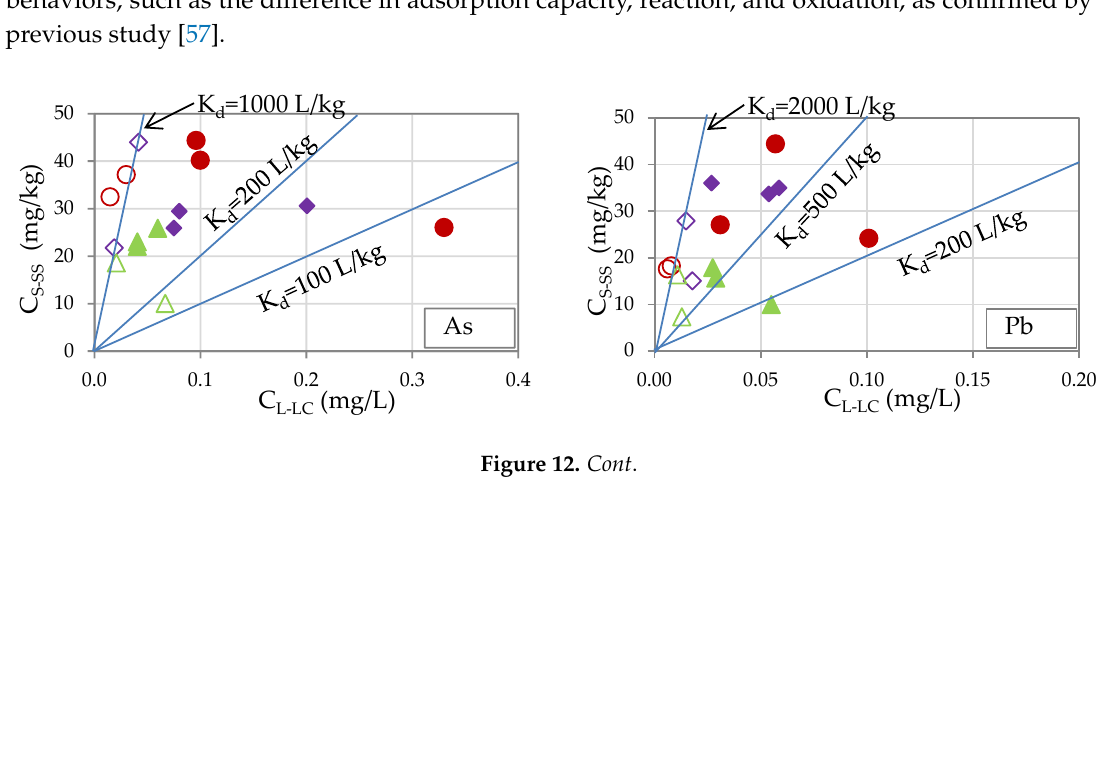
Figure 11. Relationship of HM concentration adsorbed in the SS (C SS *C S-SS ) and total heavy metal concentration of Leachate (C T-LC ).